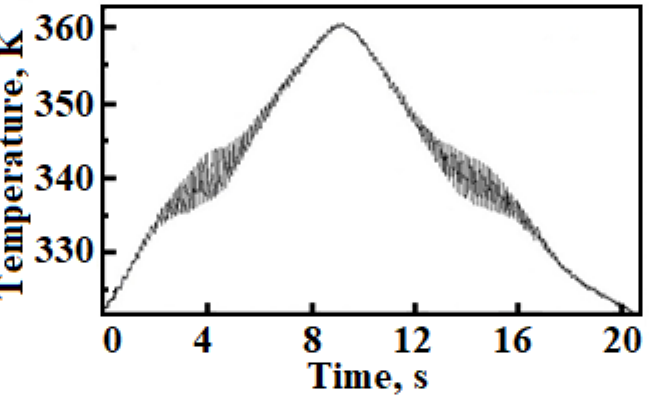
Figure 5. The dependence of the temperature of the sample on time during heating and cooling at a cycle frequency of the driving force of 10 Hz. The maximum load of 100 MPa.